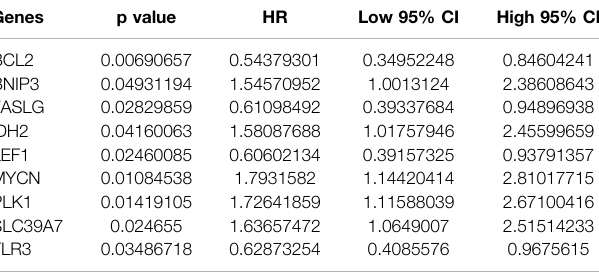
TABLE 2 | Necroptosis genes with prognostic signi fi cance in disease-speci fi c survival analysis. Genes